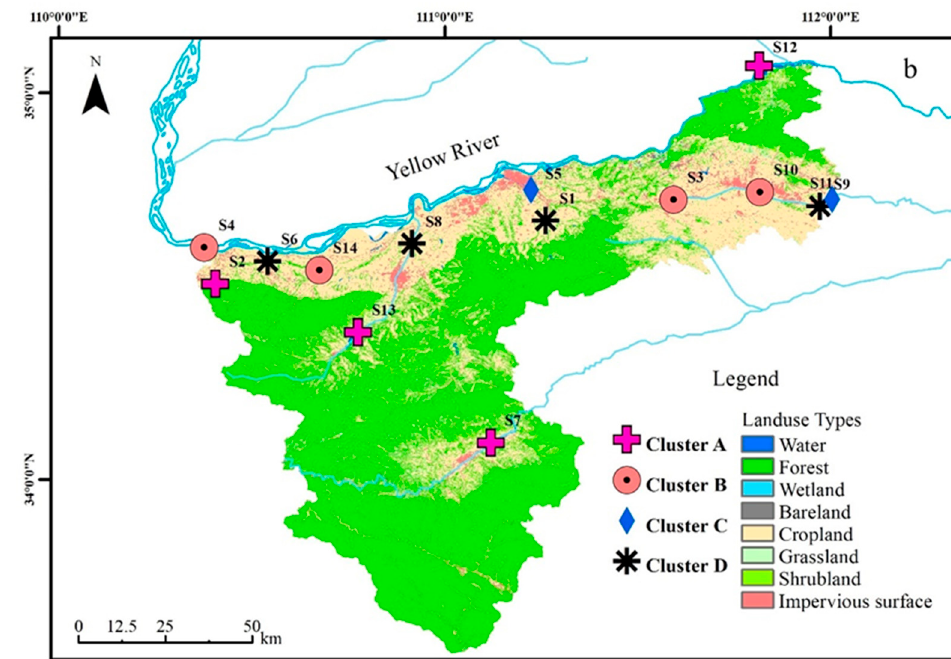
Figure 5. ( a ) Visualization of six water quality indicators for all sampling periods and sites by SOM Toolbox, ( b ) classification of sampling sites.